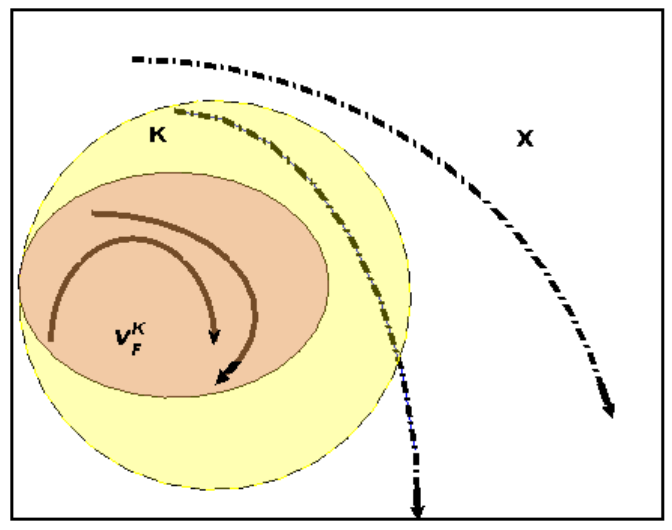
Figure 1. The viable and non viable trajectories for a time-invariant dynamic system. The state constraint set K is represented by the yellow (or light shaded) round contour contained in state-space X . The solid and dashed lines symbolise system evolutions, which converge to where the arrows